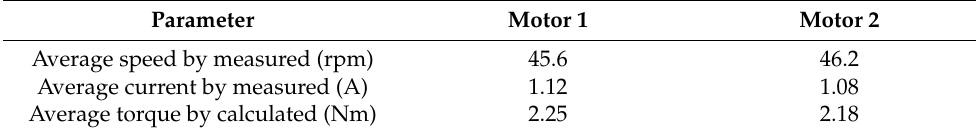
Table 7. Parameters of motor characteristics.